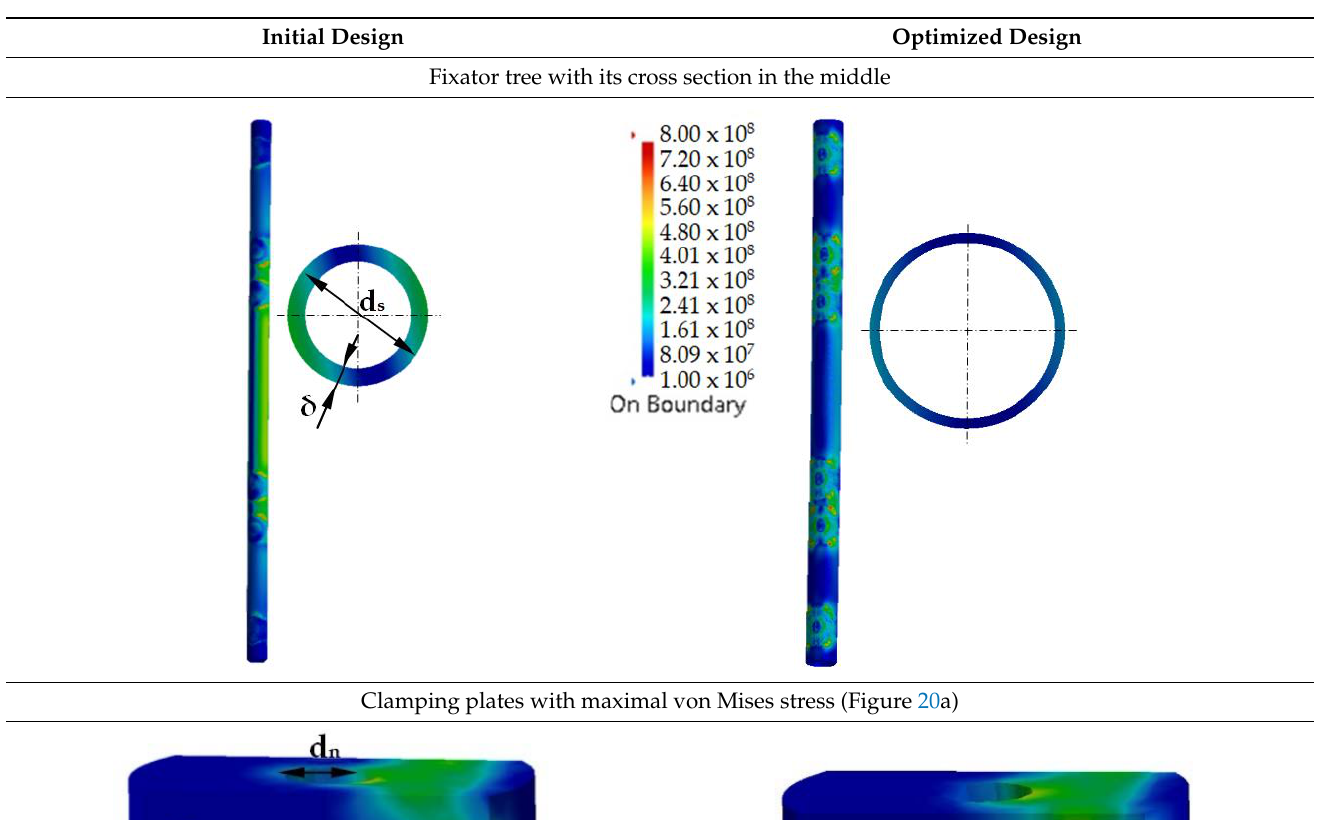
Table 8. Distribution of von Mises stresses on fixator components for initial and optimized design.